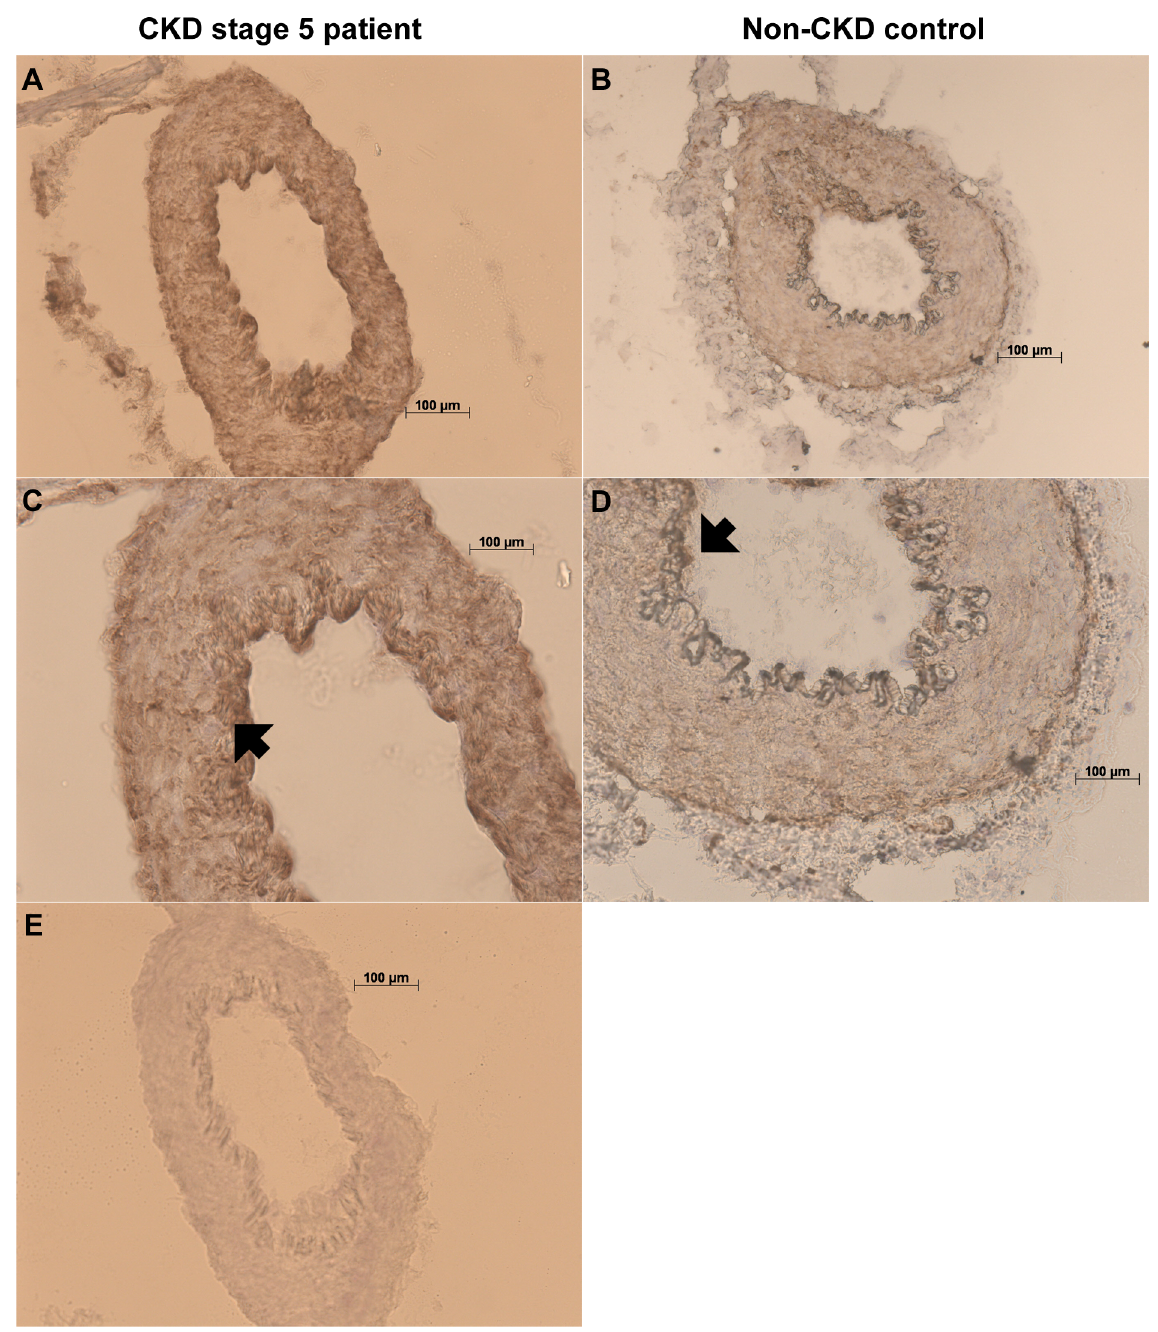
Figure 3. Positive immunohistochemical staining of PTX3 in resistance subcutaneous arteries from CKD stage 5 patients. Positive staining (brown) is shown in representative biopsies of CKD-5 patients (A, C) and non-CKD controls (B, D). No immunoreactivity was observed when anti-PTX3 antibody was absent (E). The PTX3-immunoreactivity is abundant in arteries, especially in endothelial cells of tunica intima, indicated by black arrowheads, both in patients (C) and controls (D). The slides were counterstained with hematoxylin. Images are magnified x10 (B), x20 (A, D, E) or x40 (C); scale bar 100 m m.